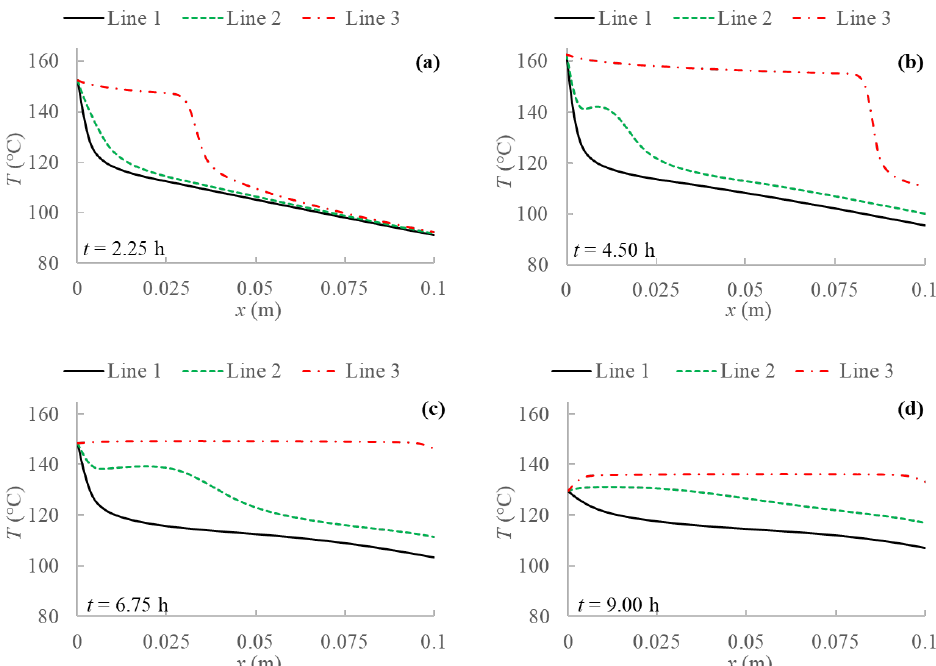
Figure 6. Temperature profiles for 2D model with natural convection and BC 2 evaluated at three different PCM transversal sections: Line 1 ( y = 0 m); Line 2 ( y = 0.05 m); Line 3 ( y = 0.1 m), and at different evaluation times: ( a ) after 2.25 h; ( b ) after 4.50 h; ( c ) after 6.75 h; ( d ) after 9.00 h from the simulation beginning respectively.